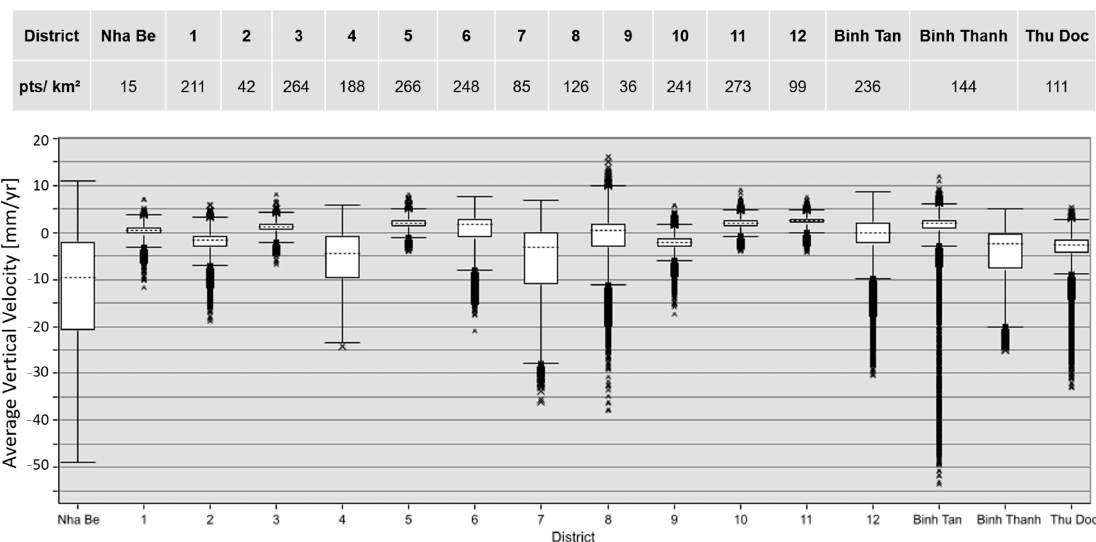
Figure 8. Box and Whisker plots of key HCMC Districts and outliers based on a standard 1.5*IQR whisker representation, with points per sq km for each key district identified in the embedded table above. Points per sq km elucidate the variance in the spread of the boxes, whiskers, and outliers in this plot.